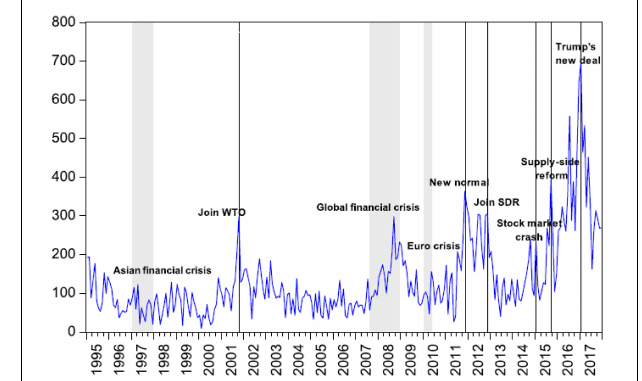
FIGURE 1 | Variations in the EPU index for